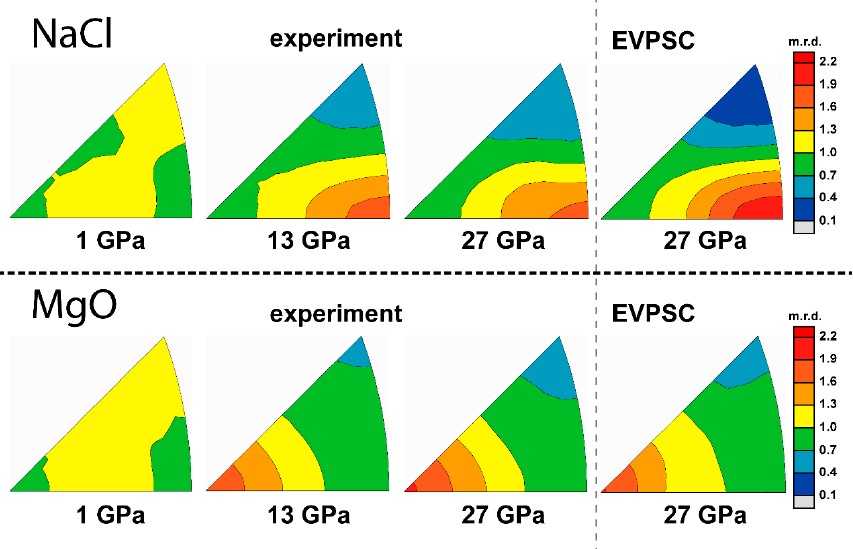
Figure 13. IPFs of experiment and modeling texture of 80% MgO + 20% NaCl. Scale bar is given in multiples of random distribution (m.r.d.)